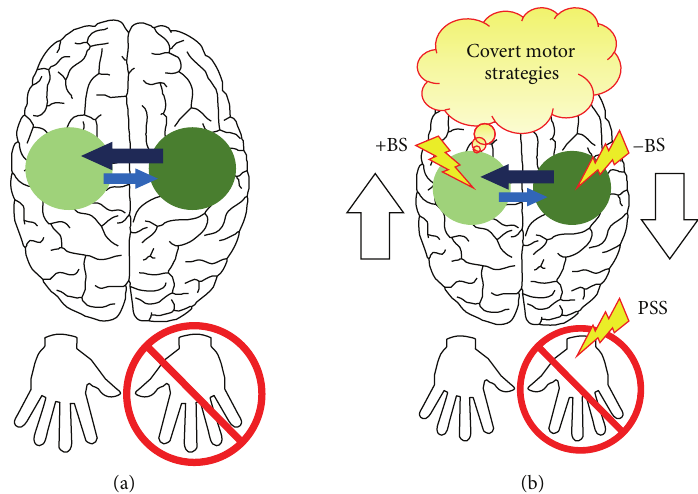
Figure 2: (a) highlights the similarity between the maladaptive neural plasticity patterns that often occur after a hemiparetic stroke and that are currently thought to play an important role in mediating the individual’s motor deficits (see Figure 1(a) for comparison) and the neural plasticity patterns that are induced by upper limb immobilisation ( red crossed circle ) in otherwise healthy individuals. Light green circle : depression, that is, decreased size and/or excitability, of the cortical motor representation(s) corresponding to the immobilised body part(s). Dark green circle : overactivity of the homologous cortical motor representation(s) in the opposite cerebral hemisphere. Light blue arrow : decreased transcallosal inhibition. Dark blue arrow : increased transcallosal inhibition. (b) indicates potential interventions that could be delivered during a paradigm of upper limb immobilisation in healthy individuals in order to prevent maladaptive or promote adaptive neuralplasticityinthemotorsystem.Theseinterventionsmightinclude,forinstance,covertmotorstrategies,suchasactionobservation(AO) and (likely) motor imagery (MI) ( red-yellow balloon ), and adjunctive therapies, such as excitatory and inhibitory brain stimulation (+BS and − BS, resp.) and peripheral somatosensory stimulation (PSS) ( red-yellow bolts ). White tick upward arrow : increase activity in the motor cortex contralateral to the immobilisation. White tick downward arrow : decrease activity in the motor cortex ipsilateral to the immobilisation. The idea here is that this might contribute to the development of alternative motor rehabilitation strategies for treating poststroke upper limb hemiparesis. See text for further